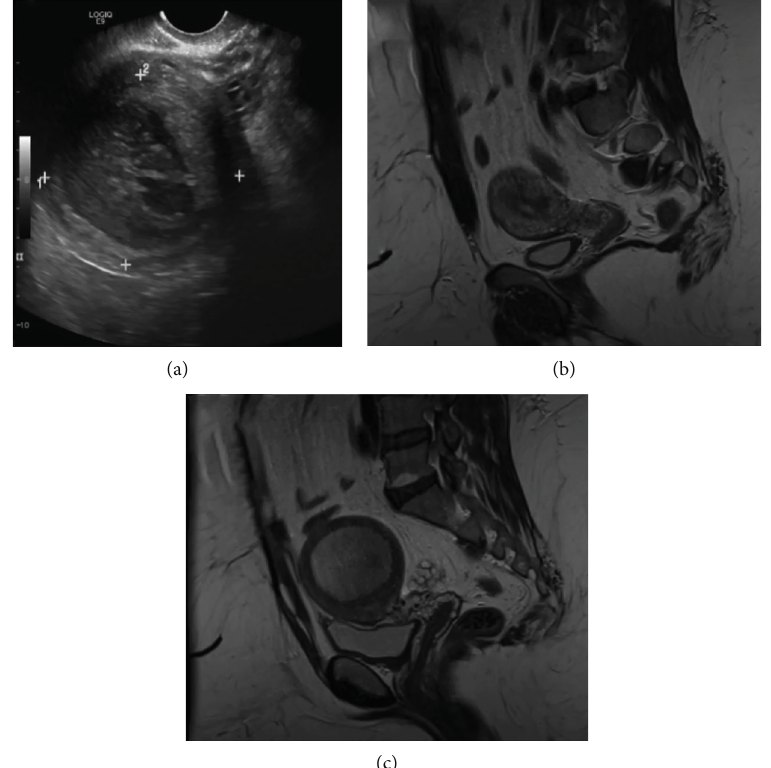
Figure 2: (a) 2D scan read as fi broid with central necrosis. (b, c) Communicating and noncommunicating horns on MRI.